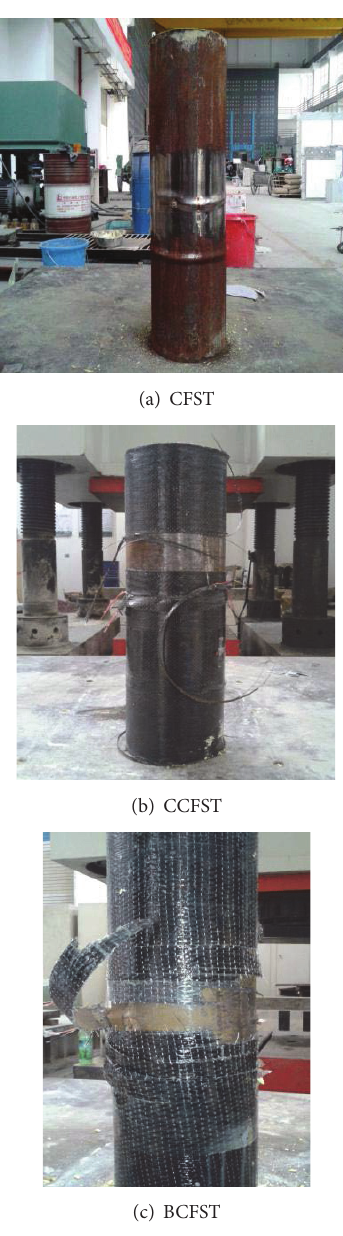
Figure 8: Failure modes of